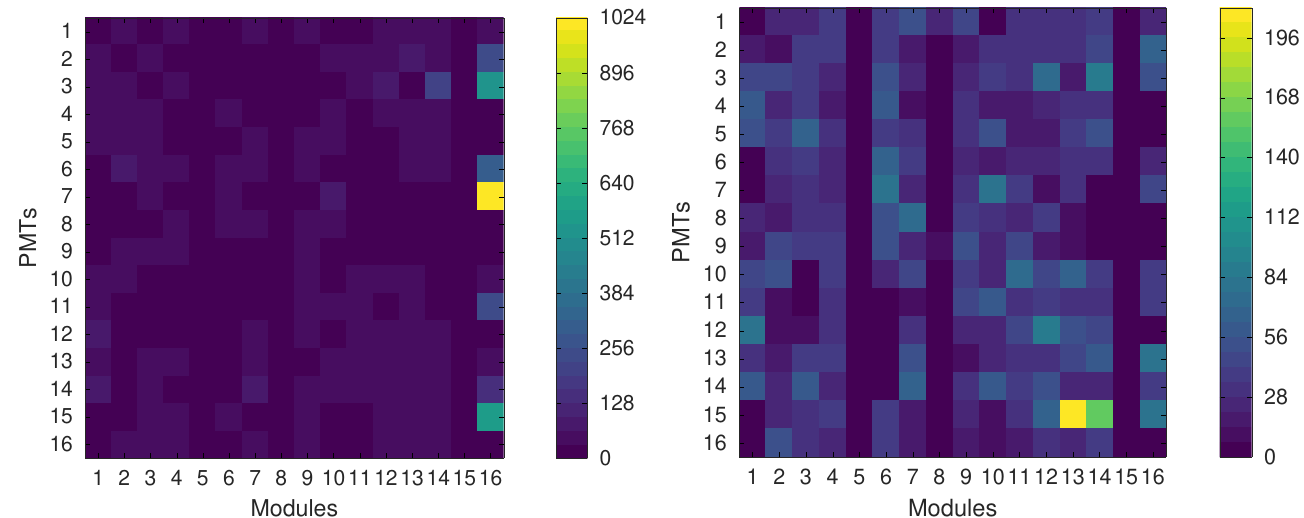
Figure 11. Examples of snapshots of the focal surface that were not classified by the CNN as produced by TLFs.